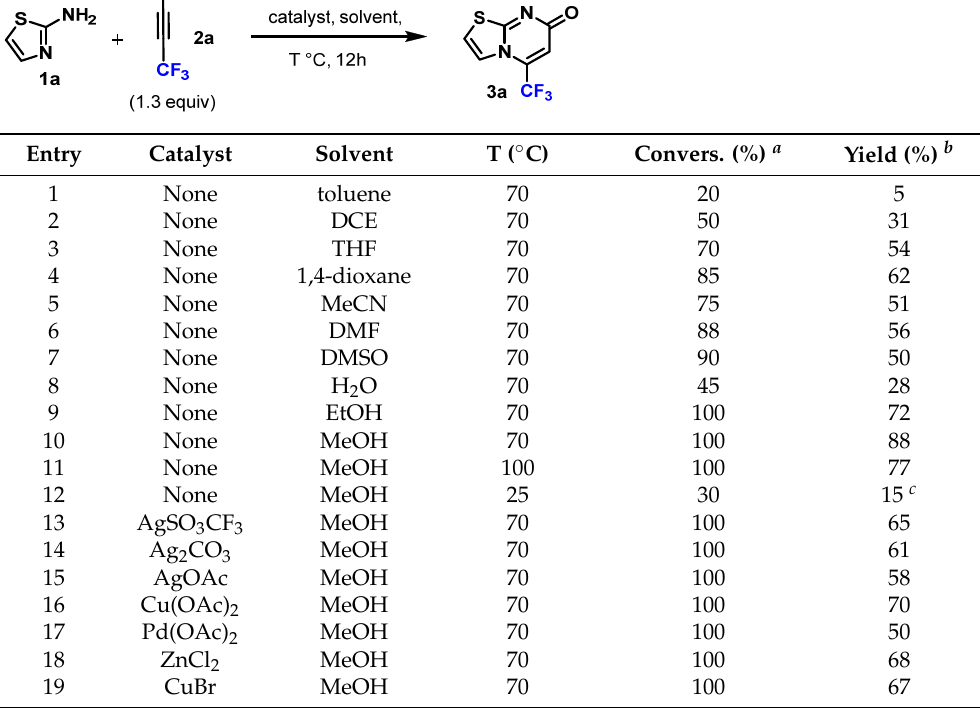
Table 1. Optimization of the reaction conditions.